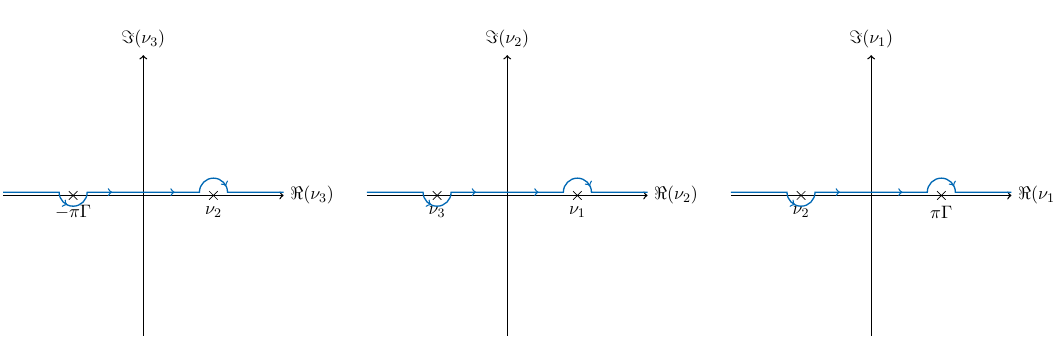
Figure 2 . The initial integration contour for the 8-gluon BFKL